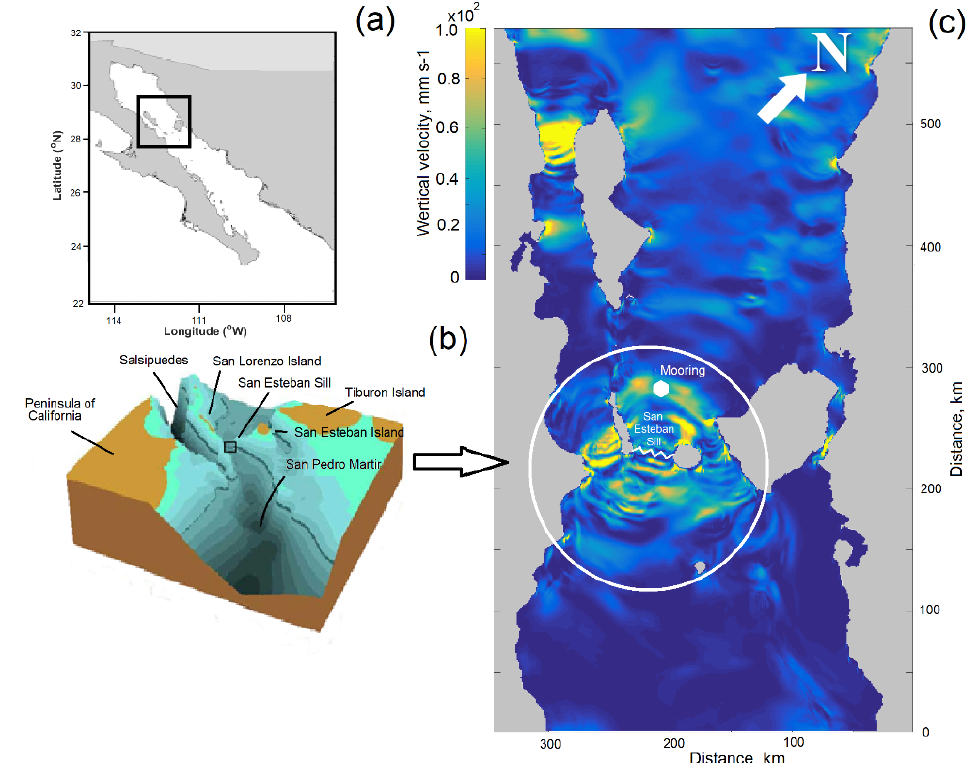
Figure 1. (a) Study area in the Gulf of California. (b) Islands and inter-island channels Figure 1. ( a ) Study area in the Gulf of California. ( b ) Islands and inter-island channels in the area in the area of San Esteban Sill (courtesy of M. Lavin). The rectangle shows the location of San Esteban Sill (courtesy of M. Lavin). The rectangle shows the location of the underwater sill. of the underwater sill. (c) Vertical component of the tidal current velocity in the study ( c ) Vertical component of the tidal current velocity in the study area, calculated using the POM area, calculated using the POM model.